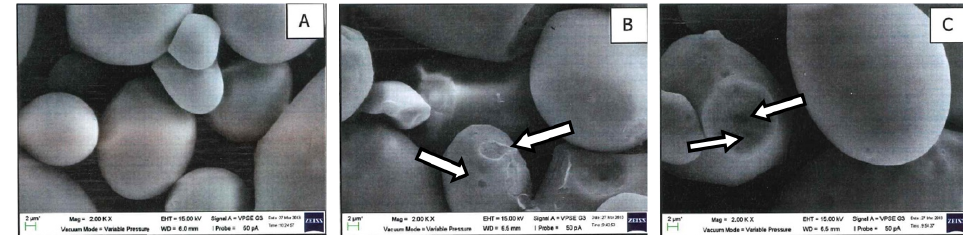
Figure 2. Scanning electron micrographs for ( A ) native sago; ( B ) ANN(T o -5); ( C ) ANN(T o -10) (2000× magnification).